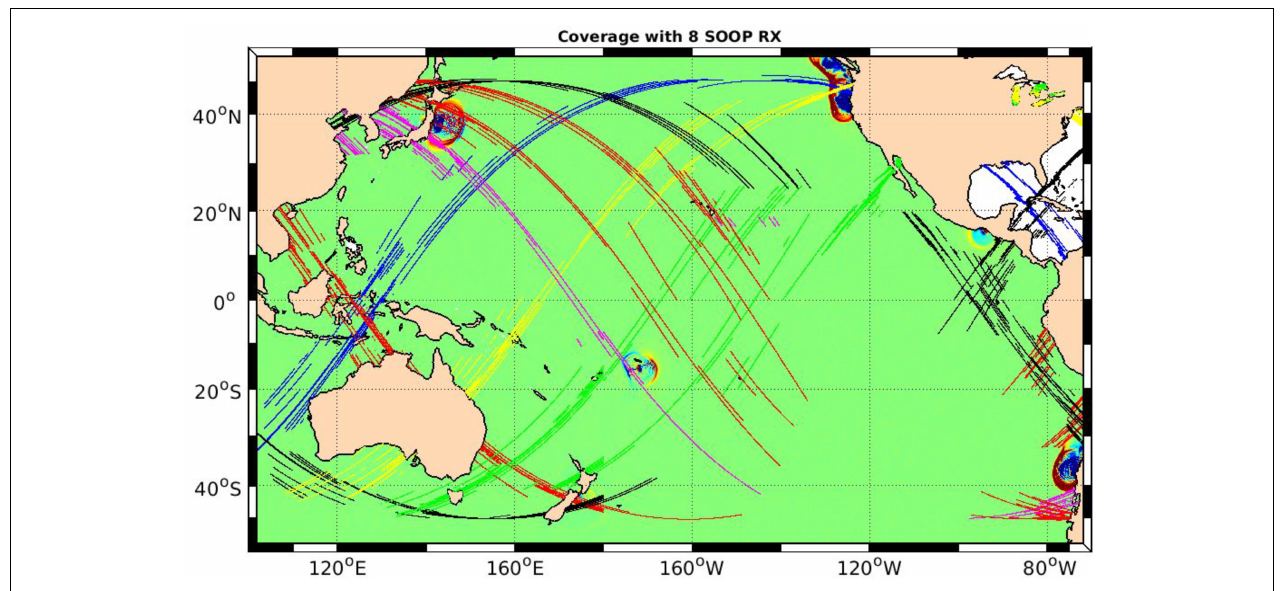
FIGURE 12 | Previously occurred tsunamis in the Pacific. Eight SoOp Receivers (different colors) are